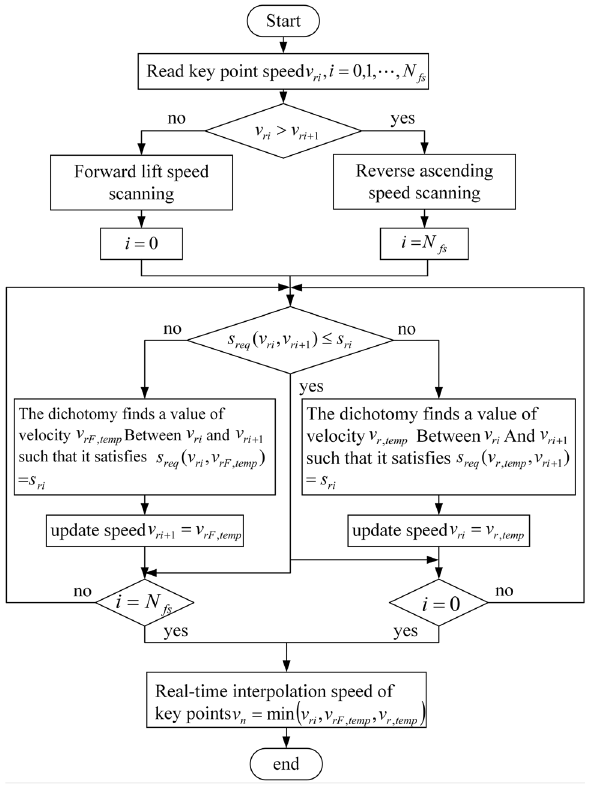
Figure 5. Update flow chart of bidirectional scanning speed of key